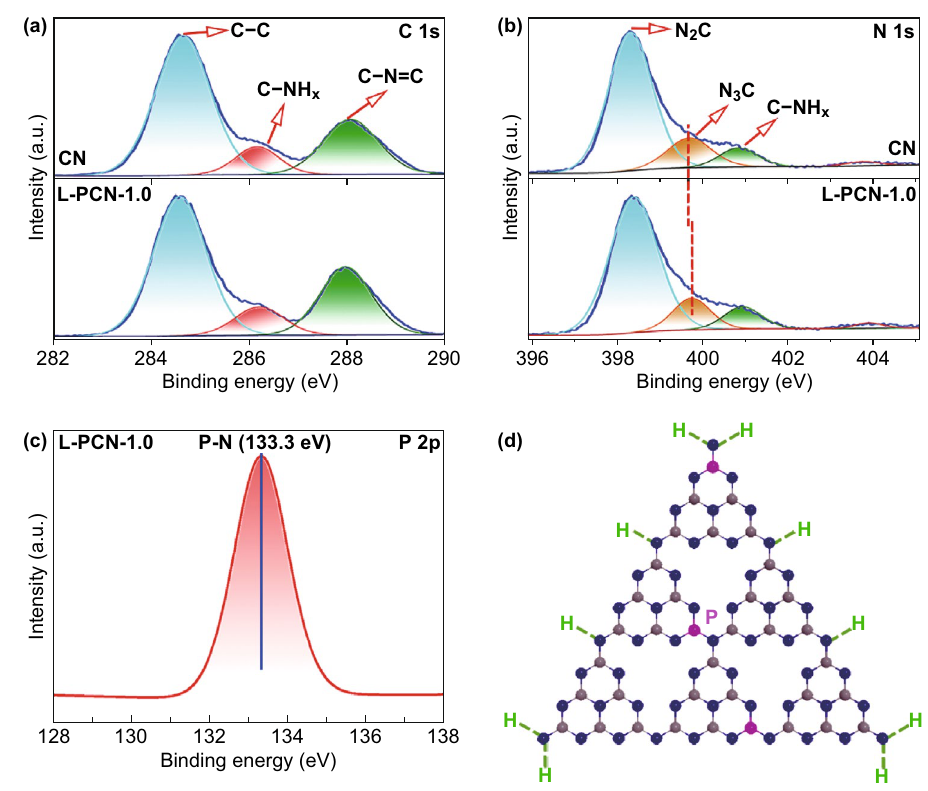
Fig. 4 Surface chemical compositions and chemical states characterization of C, N, and P elements for CN and L‑PCN. a – c High resolution of C 1 s , N 1 s , and P 2 p XPS spectra of CN and L‑PCN‑1.0. d Proposed structure of L‑PCN (carbon, nitrogen, and phosphorus atoms are, respec‑ tively, indicated by gray, blue, and pink spheres in the atomic model). (Color figure